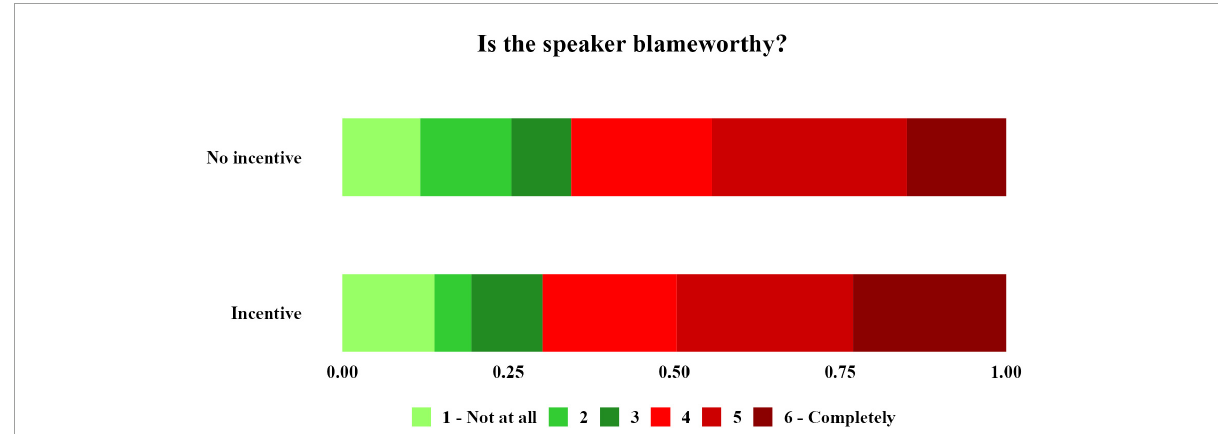
FIGURE1 Distribution of participants’ total responses to the blame question. There is a shift towards greater blame in the incentive condition. That is, participants tended to blame the speaker significantly more for misleading the audience when the speaker had prior incentives to do so, independently of the presence of their